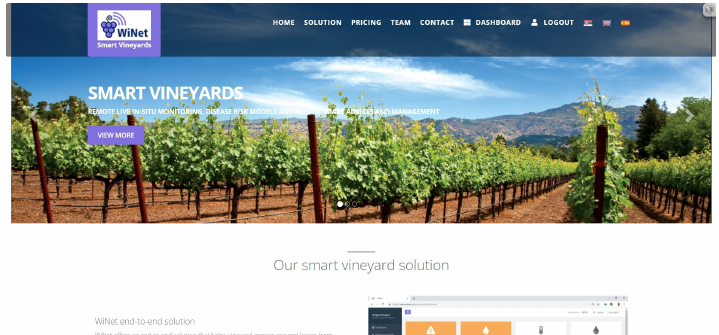
Figure 9. The Winet Web application—home page.